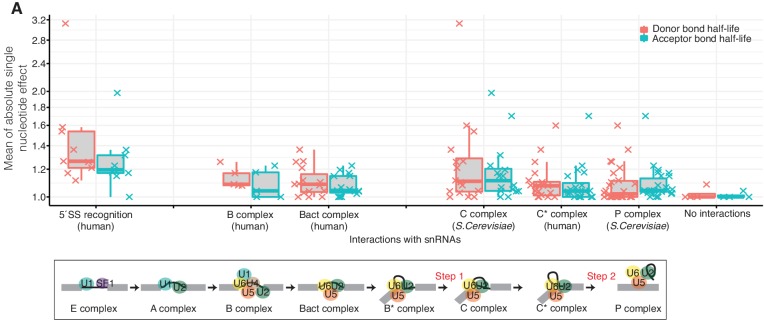
Effects of nucleotide changes on splicing kinetics as the spliceosome proceeds.(A) Distribution of the mean absolute effect of single nucleotide effects on donor and acceptor bond half-lives for the reported interactions between the precursor RNA and the snRNAs of the available spliceosomal complex structures for 5´splice-site recognition (Kondo et al., 2015), B-complex (Bertram et al., 2017a), Bact complex (Haselbach et al., 2018), C complex (Galej et al., 2016), C*-complex (Zhang et al., 2017), and P-complex (Bai et al., 2017) (top). Schematic representation of snRNAs during the different splicing stages (bottom). (Based on Supplementary file 4).